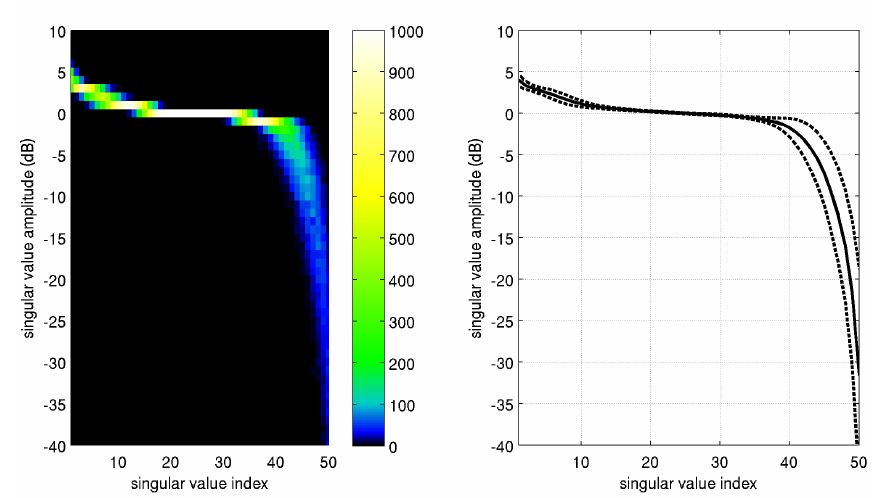
Figure 8. Singular values analysis for d = λ /2 and K = 50. ( Left ) Image map of the distribution of each one of the 50 singular values; ( Right ) solid line, average singular values; dashed lines, average singular values ± the standard deviation of the